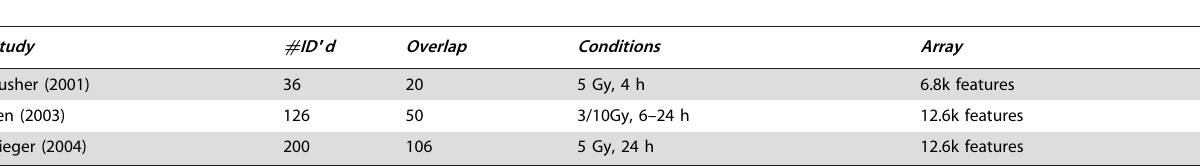
Table 3. Comparison of overlap between this study, and other published gene expression microarray radiation response papers.